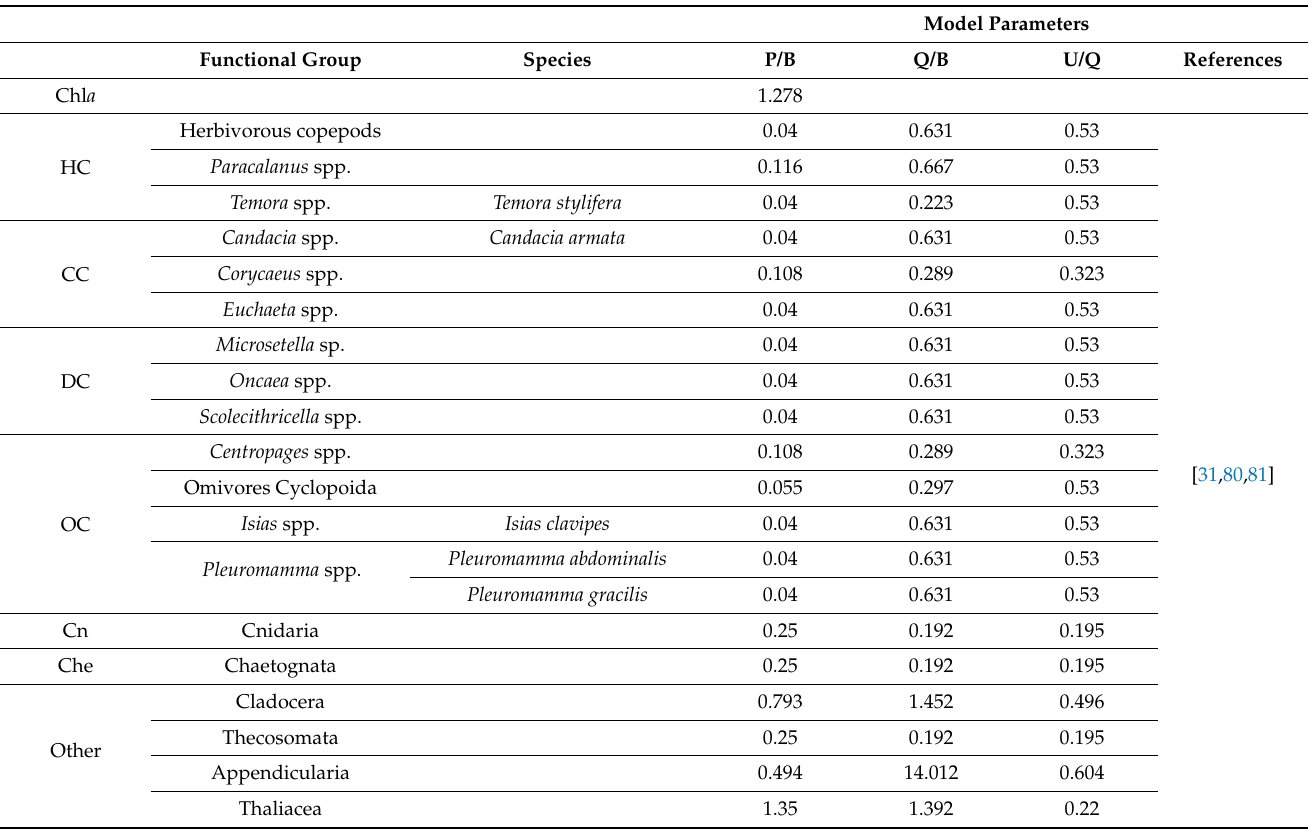
Table A2. List of model